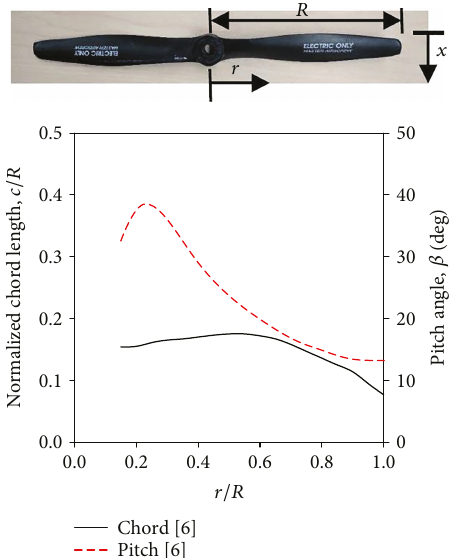
Figure 5: Geometry of Master Airscrew Electric 11x7 (MAE 11x7).